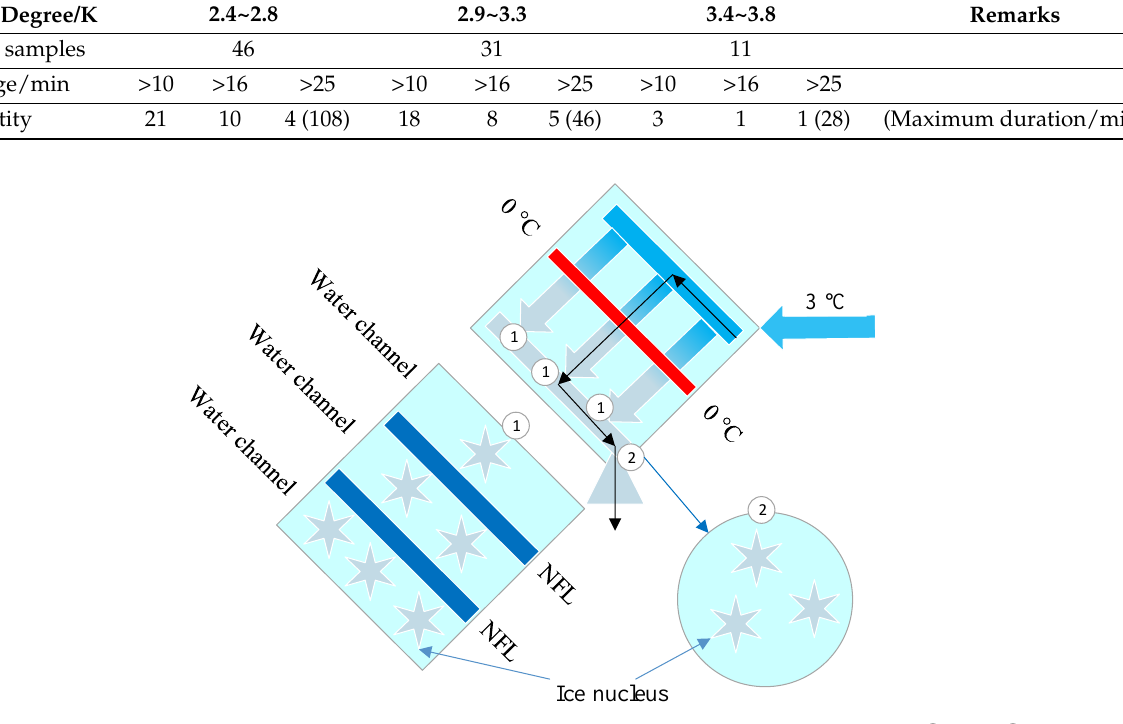
Figure 7. Schematic of ice nucleus formation in heat exchanger channels. ① and ② represent the locations that cause perturbations in the subcooled water such that ice nucleus are generated. The symbols of gray stars represent ice nucleus.